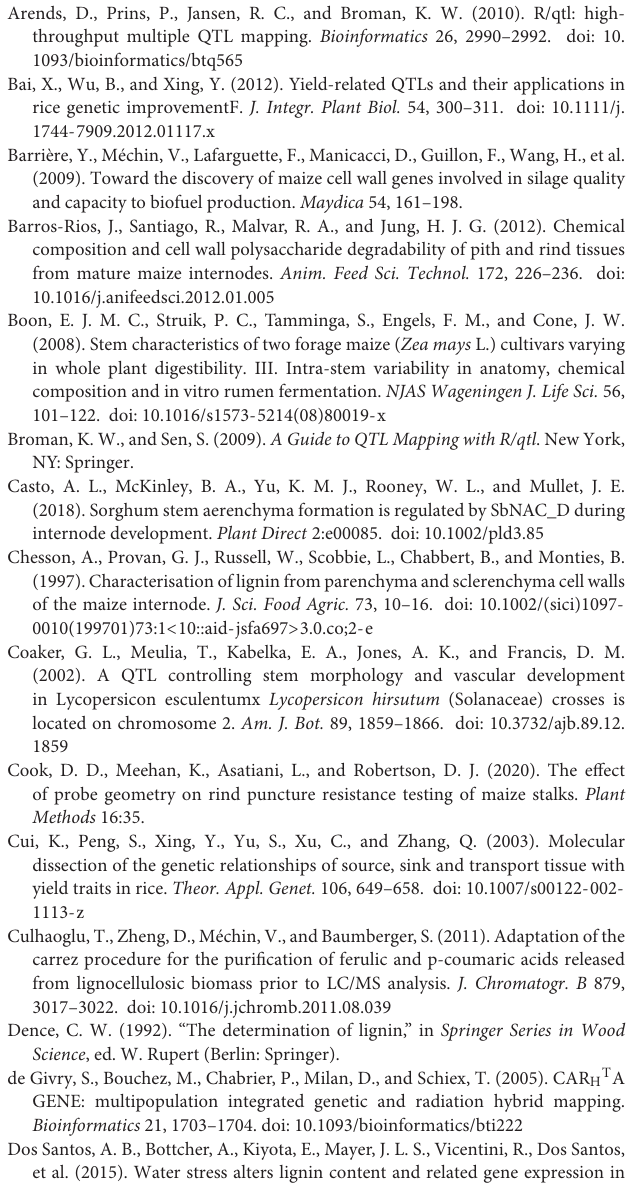
Supplementary Table 3 | Cos2 and Pearson correlation of all the traits for the two first axes of the PCA. Supplementary Table 4 | Pearson correlation table of all the biochemical and histological traits for the RILs in each field trial: 2014.I, 2014.NI, 2015.I, and 2015.NI. Supplementary Table 5 | List of QTL detected for all the histological, biochemical, and agronomical traits. When the effect sign is positive, Cm484 alleles are responsible of the increase of the trait; when the effect sign is negative, the alleles from F271 are increasing the trait